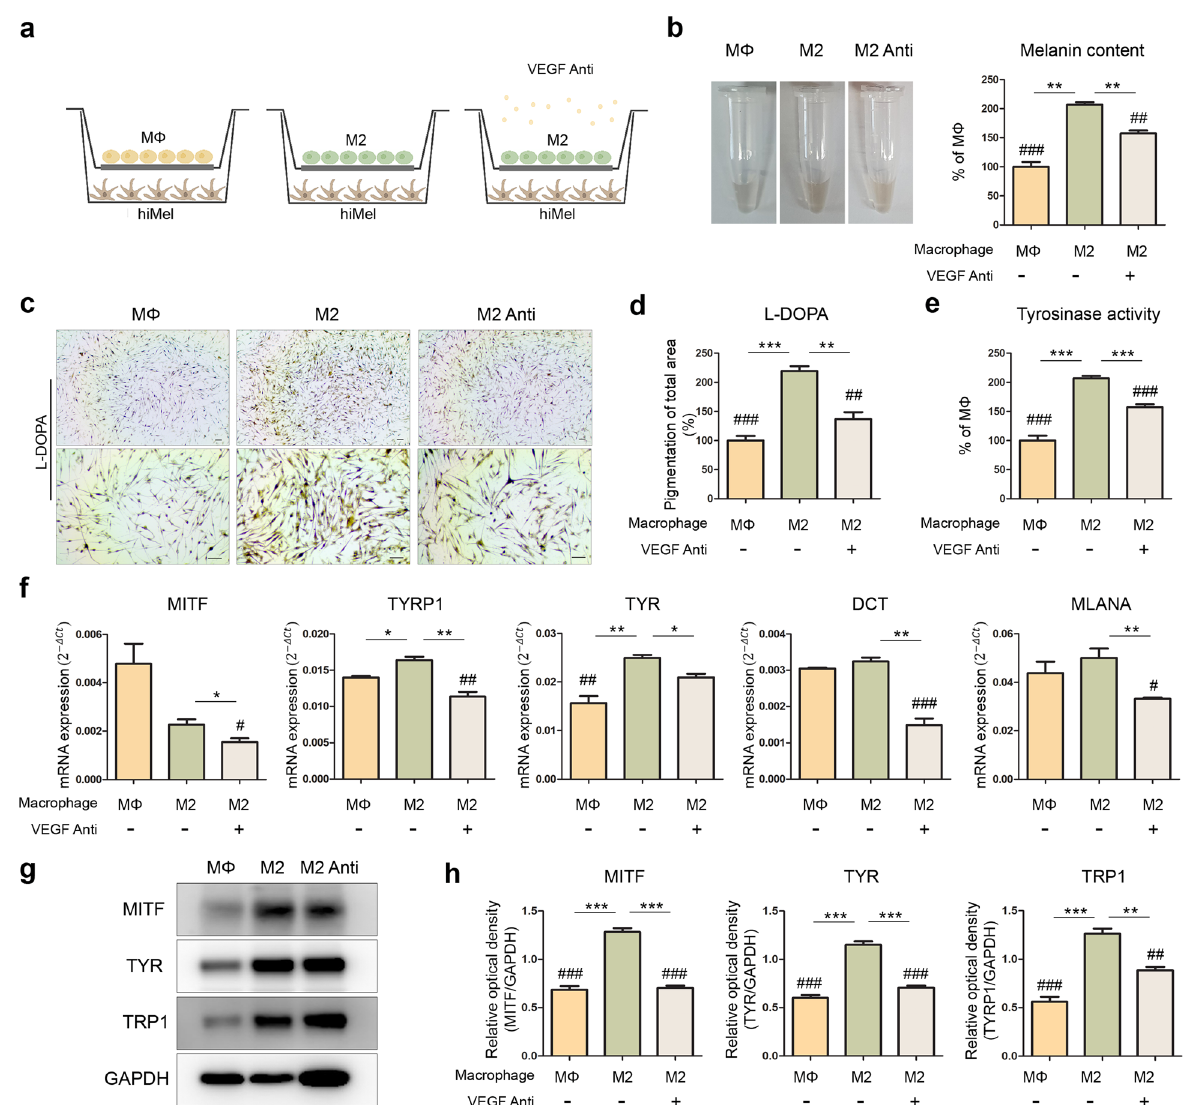
Figure 5. Neutralizing of hVEGF in hiMels cocultured with M2 macrophages. ( a ) Schematic diagram showing 5-day coculture of hiMels and M2 macrophages with or without 120 ng/mL human VEGF165 Antibody. ( b ) Melanin content of hiMels measured on day 5 coculture. ( c ) Pigmentation of cocultured hiMels with or without VEGF antibody by L-DOPA staining. Scale bar indicates 100 µm. ( d ) Quantitative measurements of L-DOPA staining area in cocultured hiMels by ImageJ software. ( e ) Quantification of tyrosinase activity in cocultured hiMels. ( f ) Quantitation of expression of pigmentation marker (MITF, TYRP1, TYR, DCT, and MLANA) in hiMels after 5 days of coculture. Relative gene expression values were calculated using the delta cycle-threshold (ΔCt) method. ( g ) Protein expression level of MITF, TYR, and TRP1 in hiMels. GAPDH was used as a loading control. ( h ) Quantification of western blotting using ImageJ software. * p < 0.05, ** p < 0.01, *** p < 0.001 ( t -test), # p < 0.05, ## p < 0.01, ### p < 0.001 vs. M2 (one-way analysis of variance) indicate statistical significance. MΦ macrophage, hiMels human induced pluripotent stem cell (hiPSCs)-derived melanocytes, VEGF anti human VEGF165 antibody, L-DOPA 3,4-dihydroxyphenylalanine, M2 anti cocultured with M2 and VEGF group than in the hiMel-M1 group. We listed M1/M2 and M2/M1 ratios in descending order (Fig. 4e). VEGF, which showed the greatest difference, was selected for neutralization in the coculture system to confirm the pig- mentation changes induced by macrophages. As a result, melanogenesis was significantly reduced by the VEGF antibody in hiMels cocultured with M2 (Fig. 5). In addition, we directly treated hiMels with VEGF and verified the changes in melanin production. VEGF treatment increased pigmentation in the melanin content assay and tyrosinase activity assay (Fig. 6c,d). Gene expression and protein expression of pigmentation markers was altered, similar to the results of coculturing cells in VEGF-treated hiMels (Fig. 6e–g). Previous studies have shown that tyrosinase protein size can be either glycosylated or deglycosylated 39,40 ; thus, in the western blot results, we observed two different forms of tyrosinase bands (Figs. 5g, 6f, respectively). The deglycosylated form of tyrosinase was detected at 60 kDa (Fig. 5g), whereas the glycosylated form appeared at 80–90 kDa (Fig. 5g). These results